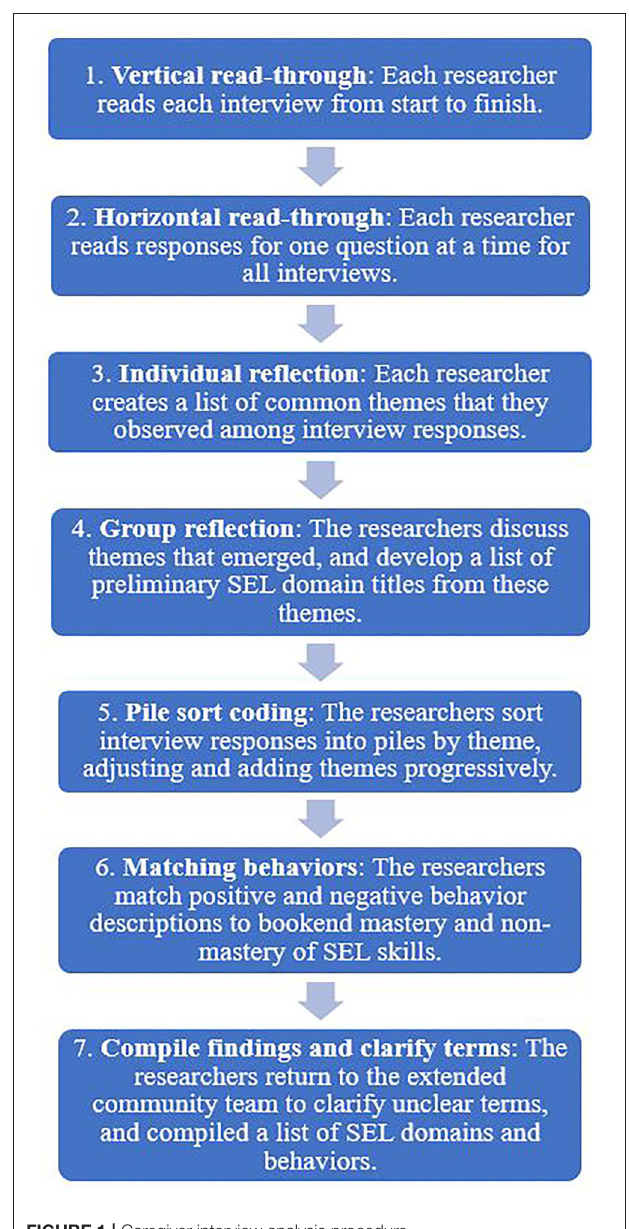
FIGURE 1 | Caregiver interview analysis